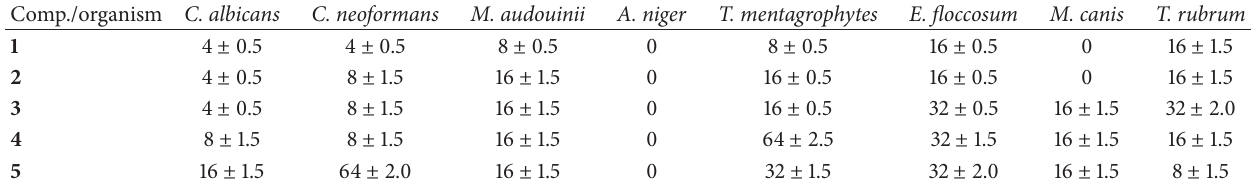
Table 4: MICs ( 𝜇 g/mL) of 1–5 from C. sativum against fungal strains. Comp./organism C. albicans